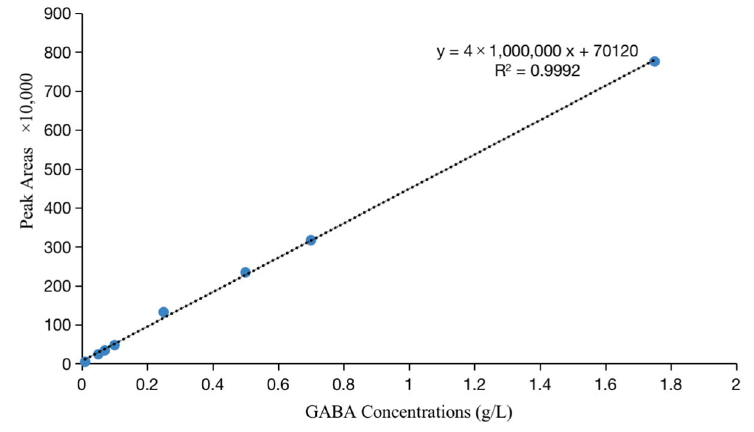
Figure 1. The standard curve of GABA in different solutions and peak areas.